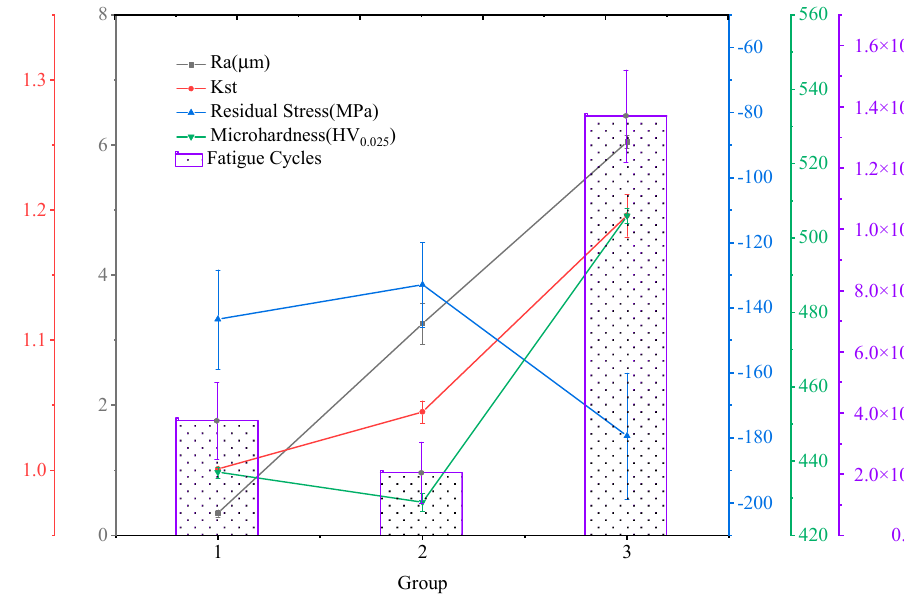
Figure 7. Fatigue test results of the specimens with different surface roughness.